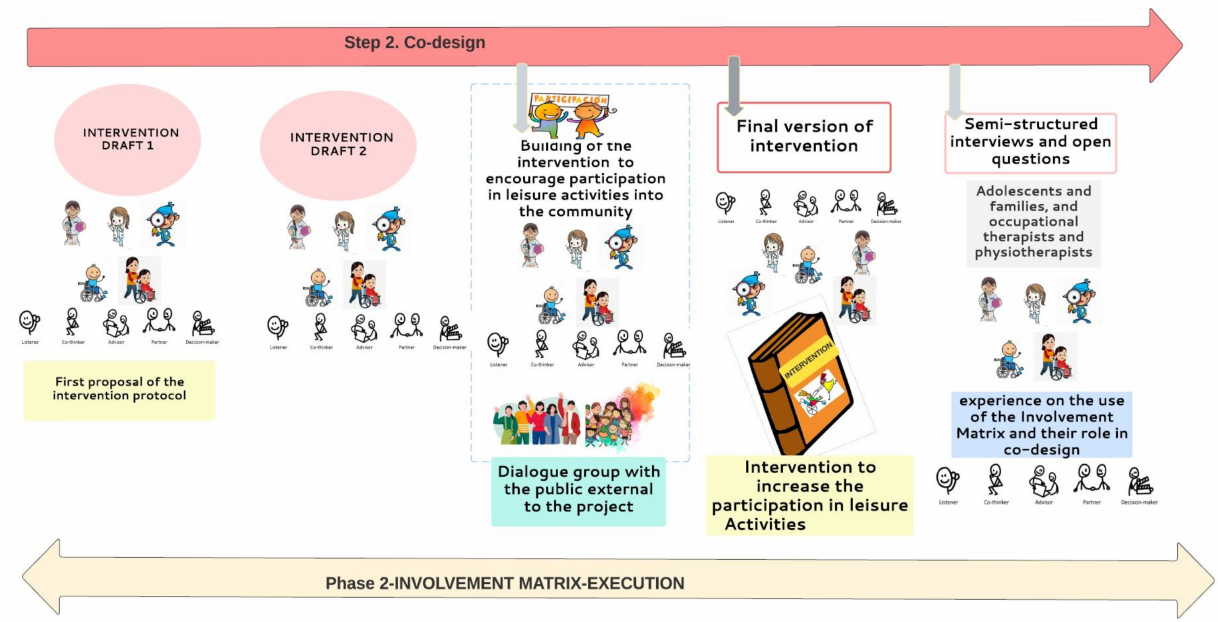
Figure 5. Step 2 of project’s research (co-design) in phase 2 of Involvement Matrix: